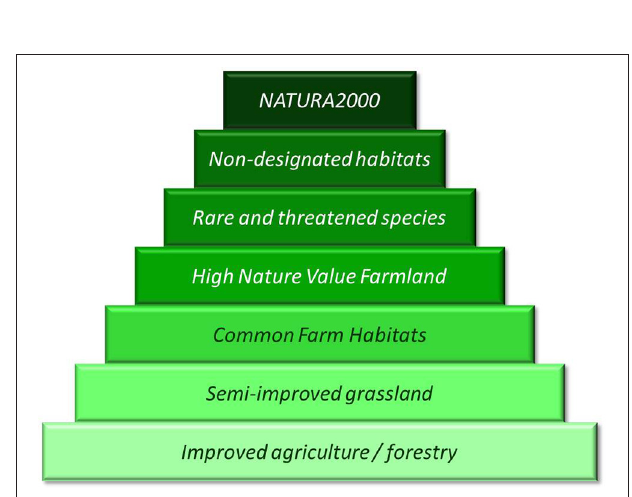
FIGURE 4 | Hierarchy of farmland ecosystems, ranked by the stringency of demands for their maintenance and protection ( O’hUallachain, 2014). Ecosystems at the bottom of the pyramid are most common and geographically widespread, but demands for their protection are least stringent, whereas ecosystems at the top occur in specific, smaller areas, but are subject to the most stringent